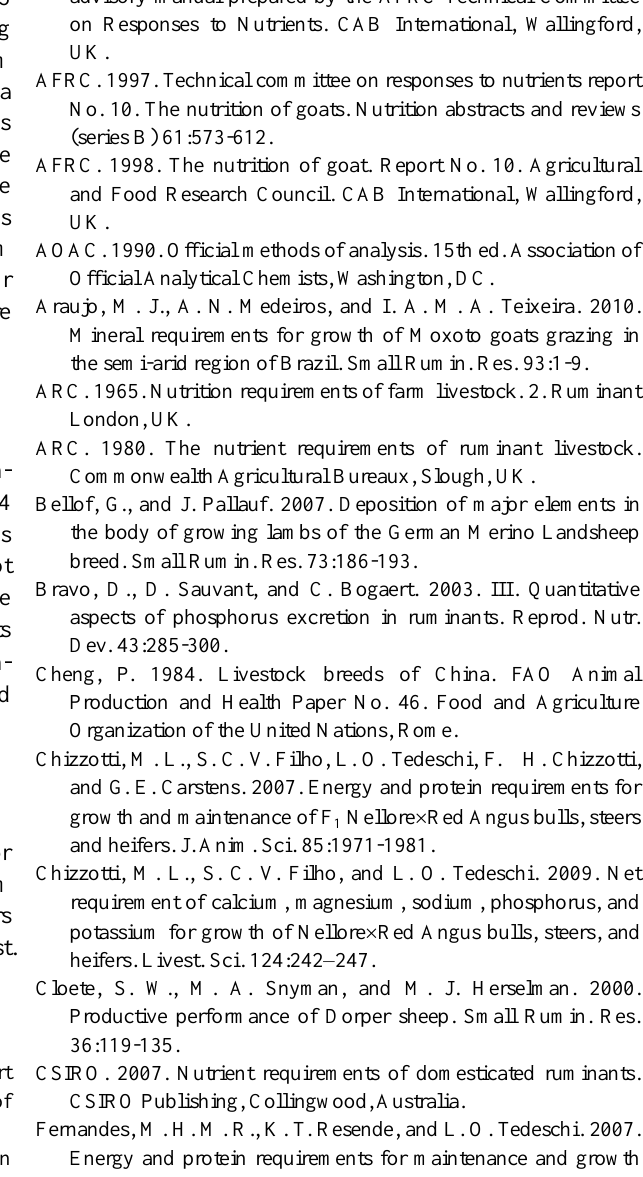
Table 4. Net P requirements of Dorper  thin-tailed Han crossbred ram lambs a Item